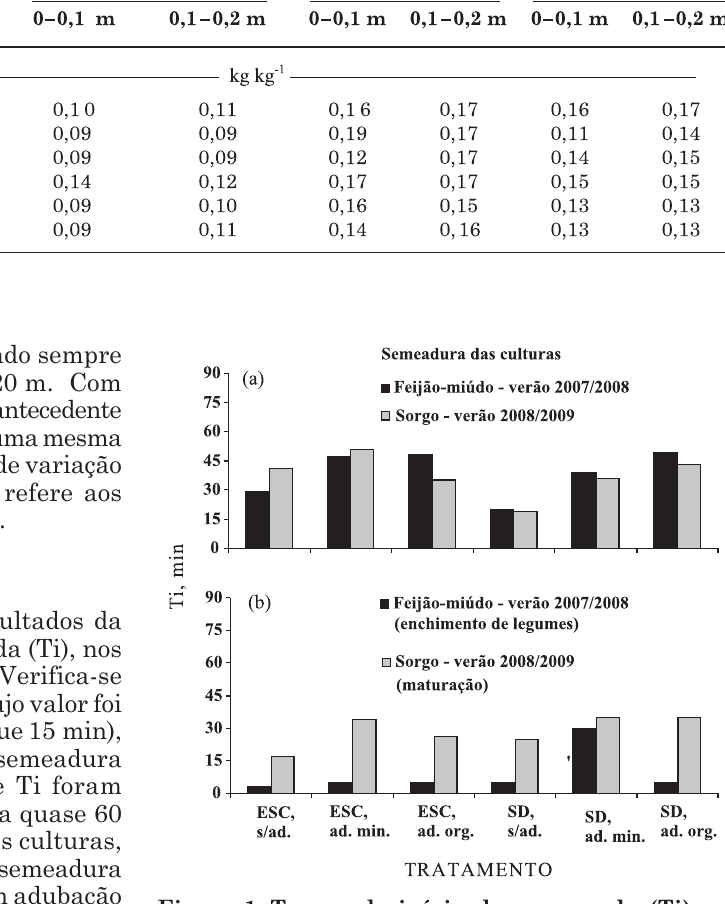
Figura 1. Tempo de início da enxurrada (Ti) nos testes de erosão realizados logo após a semeadura das culturas (a) e no estádio fenológico de enchimento de legumes do feijão- miúdo e no de maturação do sorgo (b), nos tratamentos